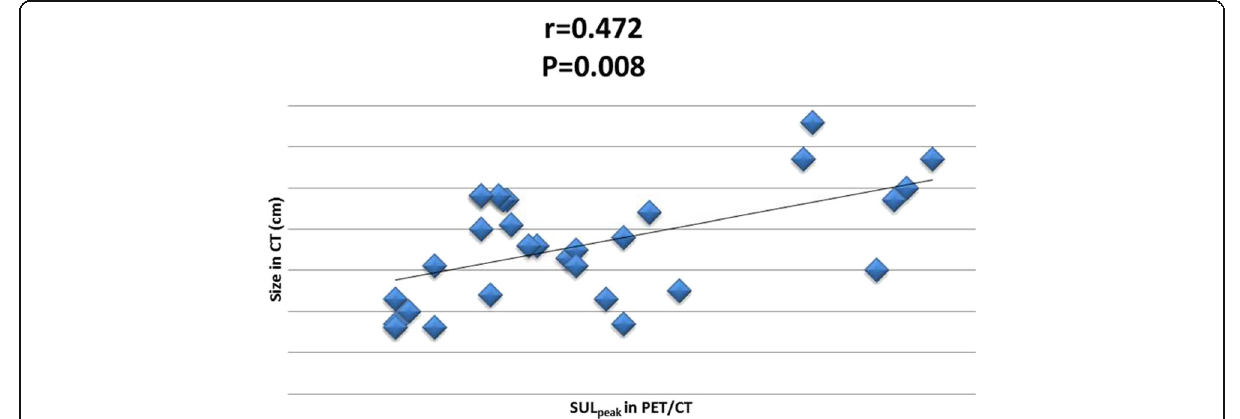
Fig. 1 Correlation between pre-chemotherapy tumor size and SUL peak among the studied